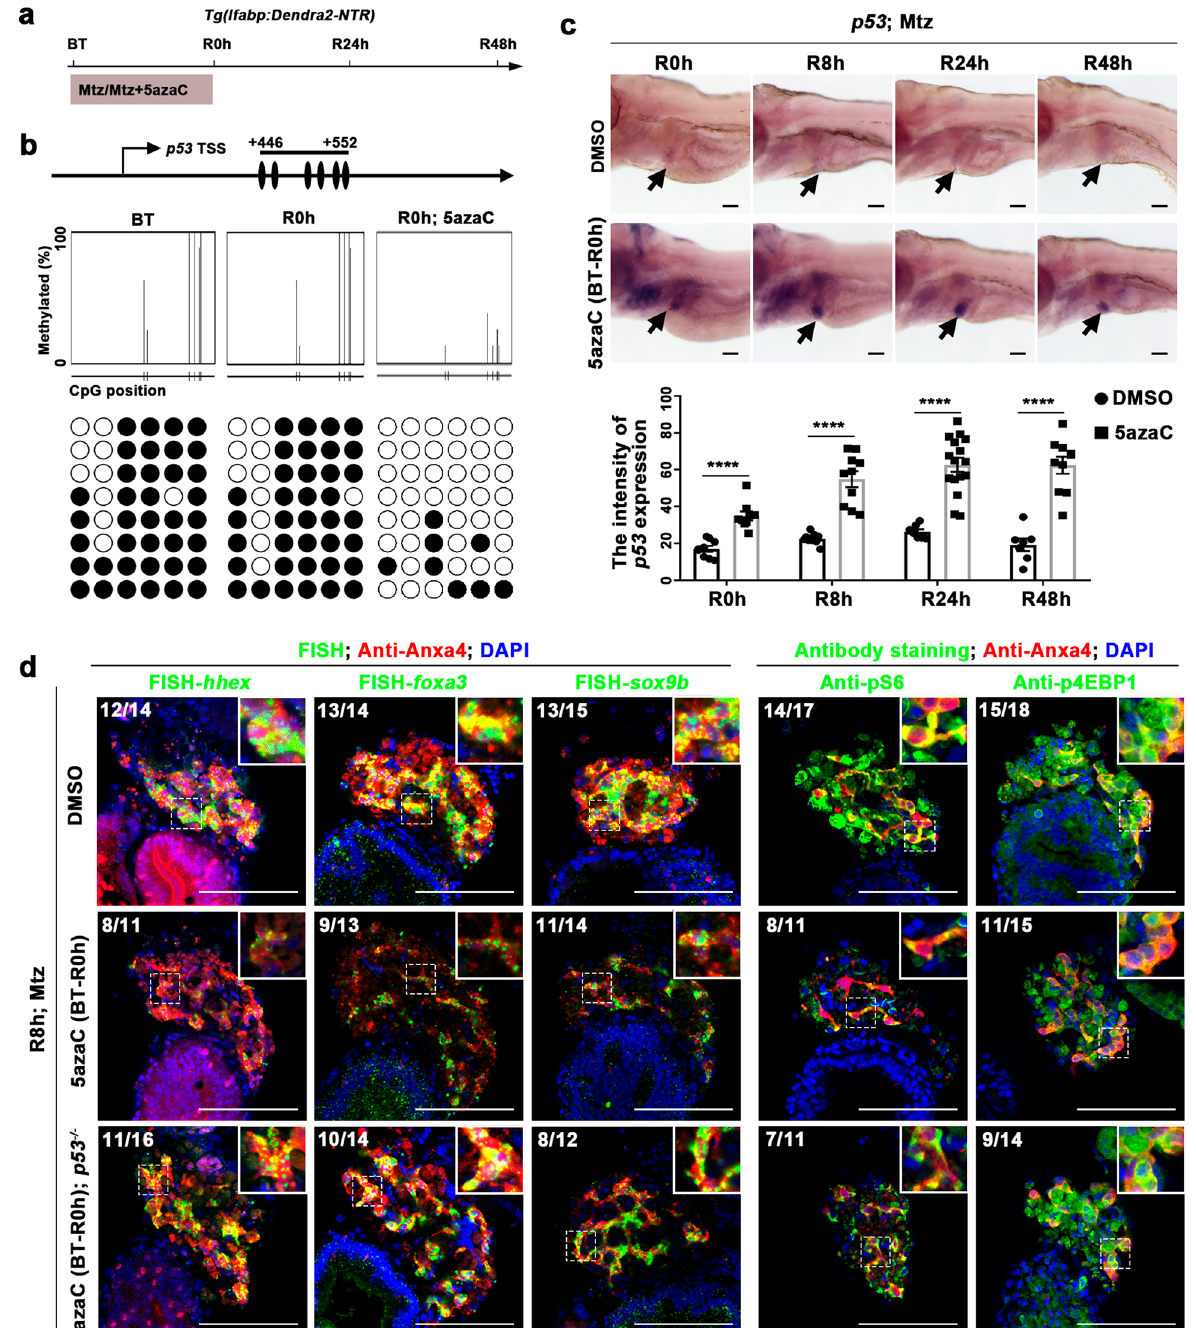
Fig. 3 Early DNA methylation inhibition reduces BEC dedifferentiation through p53 activation. a Experimental scheme illustrating the 5azaC and Mtz treatment and analysis from R0h to R48h. b Bisul fi te sequencing analysis of DNA methylation at CpG islands near the promoter at the p53 locus in DNA isolated from DMSO and 5azaC-treated livers at BTand R0h. c WISH images showing the expression of p53 during liver regeneration after early DNA methylation inhibition. Quanti fi cation of the intensity of p53 expression in liver regions from R0h to R48h. d Single-optical section images showing the expressions of hepatoblast markers hhex , foxa3 , sox9b , and mTORC1 effectors pS6 and p4EBP1 at R8h in WT and p53 mutant after early DNA methylation inhibition. Note that the expressions of hepatoblast markers and mTORC1 signaling were rescued in p53 mutant compared with WT after early DNA methylation inhibition. Asterisks indicate statistical signi fi cance: **** P < 0.0001 using t -tests analysis when compared to control. Numbers indicate the proportion of larvae exhibiting the expression shown. Scale bars: 100 µm; error bars, ±SEM. DAPI 4 ′ , 6-diamidino-2-phenylindole, BT before treatment, FISH fl uorescent in situ hybridization, R regeneration time after the withdrawal of